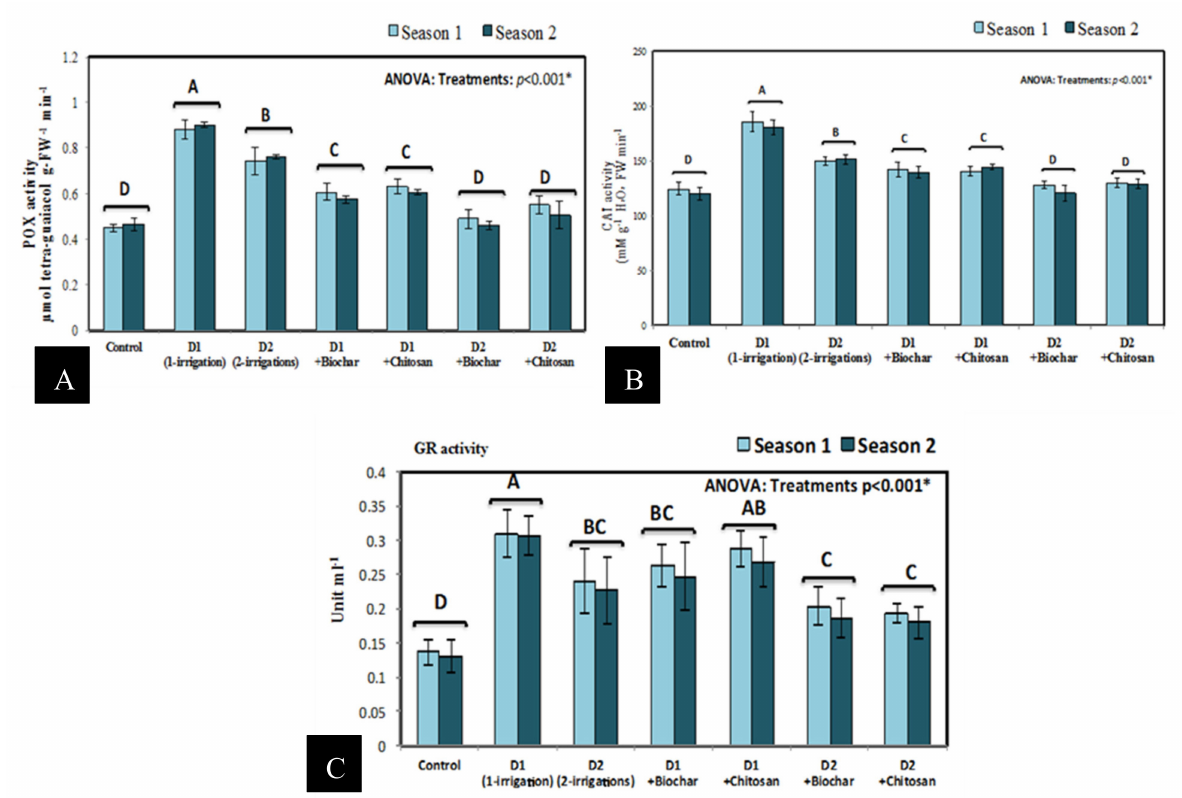
Figure 4. E ff ect of biochar and chitosan on antioxidant enzymes activity POX ( A ), CAT ( B ), and GR ( C ) of barley during two seasons (2017 / 2018–2018 / 2019). Bars followed by di ff erent letters are significantly di ff erent at p <